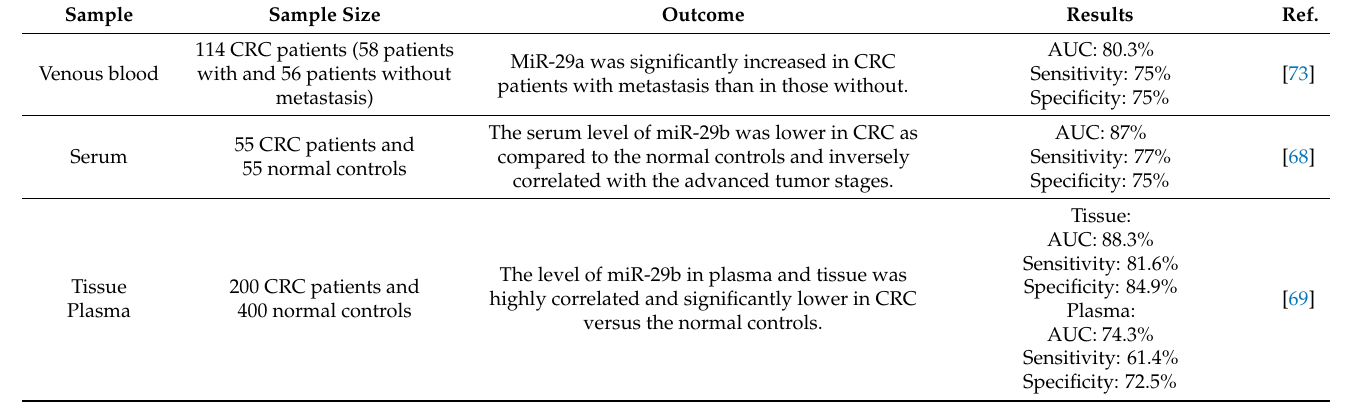
Figure 3. Potential functions of miR-29s in PI3K/AKT signaling pathways. MiR-29s directly inhibit the transcription of various PI3K/AKT downstream factors, resulting in the suppression of cell proliferation, angiogenesis, cell migration, and metastasis, while causing induction of cancer cell apoptosis. Table 1. The potential use of miR-29s as biomarkers in colorectal cancer.